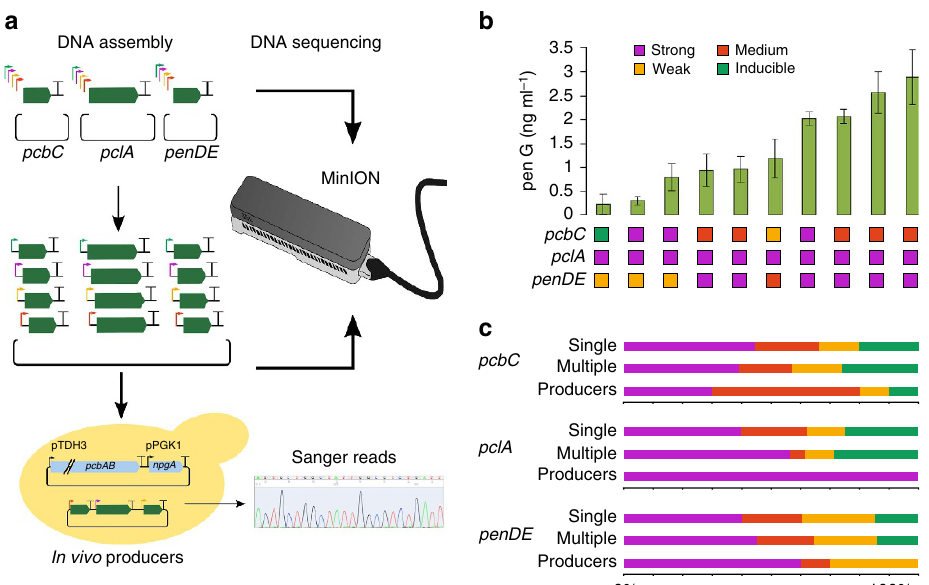
Figure 2 | Optimization of benzylpenicillin production in S. cerevisiae . ( a ) Construction and sequencing of a library with alternative promoters for pcbC , pclA and penDE . Ten different promoters of four categories (strong, medium, weak or inducible) were randomly used to drive expression of each of the genes responsible for conversion of ACV to benzylpenicillin. Plasmid libraries of single genes with different promoters were initially constructed and then pooled to randomly assemble a multigene plasmid library. Single gene and multigene libraries were subjected to MinION nanopore sequencing. The multigene library was transformed into ACV producer Sc.A2 and transformants producing benzylpenicillin were Sanger sequenced to reveal identity of promoters. ( b ) Concentrations of benzylpenicillin secreted into the supernatant by the ten yeast strains selected from the promoter screen. The best producing strain makes B 3ngml (cid:2) 1 of benzylpenicillin as determined by LCMS. Under each bar, the category of the promoter in front of each gene is shown. Error bars represent s.e.m. from three biological replicates. ( c ) Comparison of the percentage of promoters from each of the four categories for each pathway gene during Golden Gate library construction (single and multiple gene steps) and among the ten benzylpenicillin producing yeast strains as determined by DNA